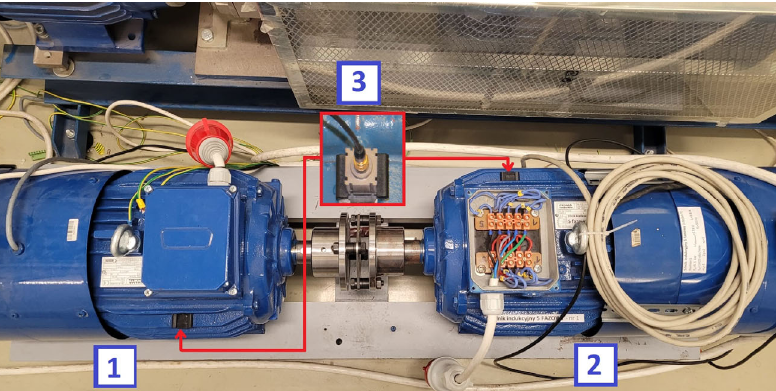
Figure 3. The tested drive unit with a 5 ‐ phase motor (1) as a driving motor and a second motor (2) as a loading motor. The number (3) indicates the locations of the accelerometers.